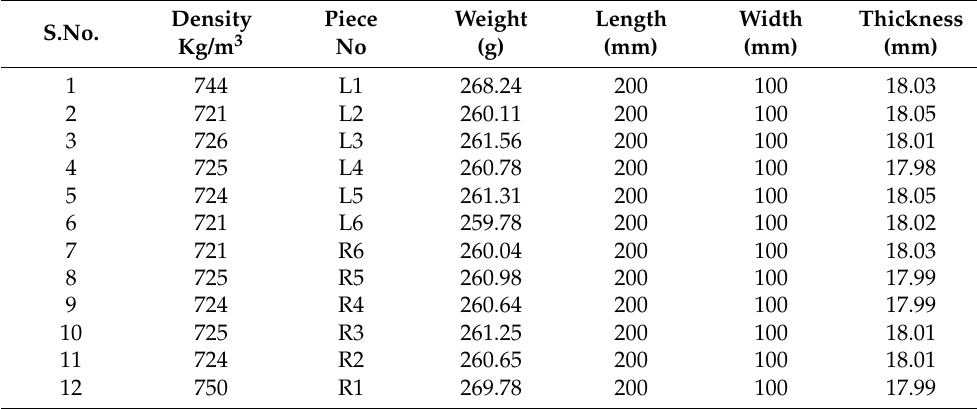
Table 20. Density profile across